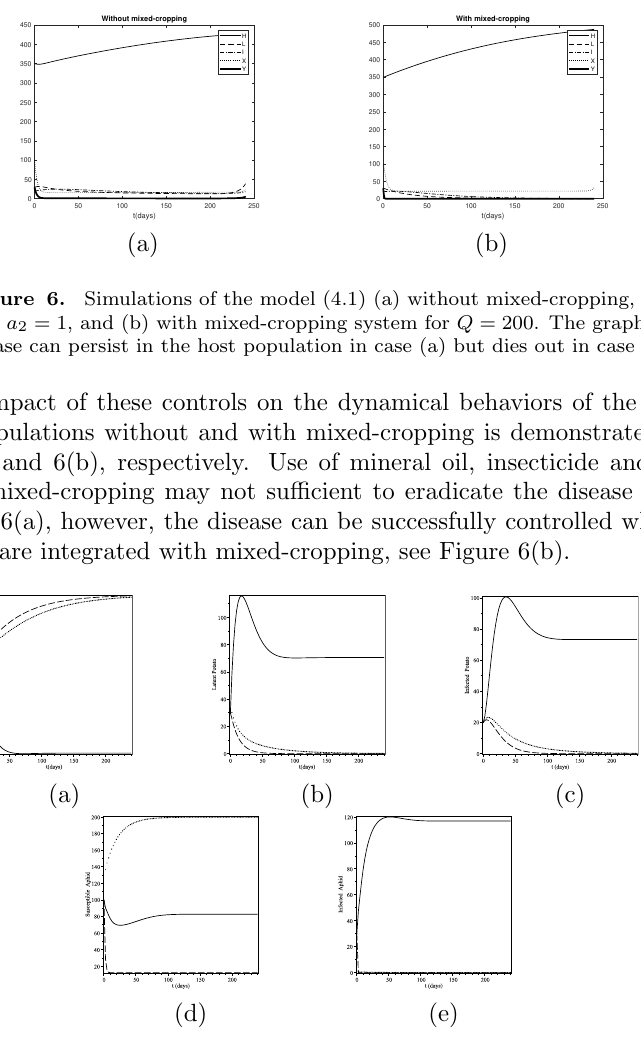
Figure 7. Simulations showing the time evolution of the host and vector populations under different situations; when mixed-cropping, mineral oil u 1 and insecticide u 2 are used (dash), mixed-cropping only, i.e. u 1 = u 2 = 0 (dot), and when no measures except u 3 are taken, i.e. Q = u 1 = u 2 = 0 , a 1 = a 2 = 1 (solid). The parameters values used are β 3 = 0 . 02 ,Λ = 10 ,a 1 = a 2 = 0 . 3 ,a 3 = 0 . 6 ,u 3 (cid:54) =